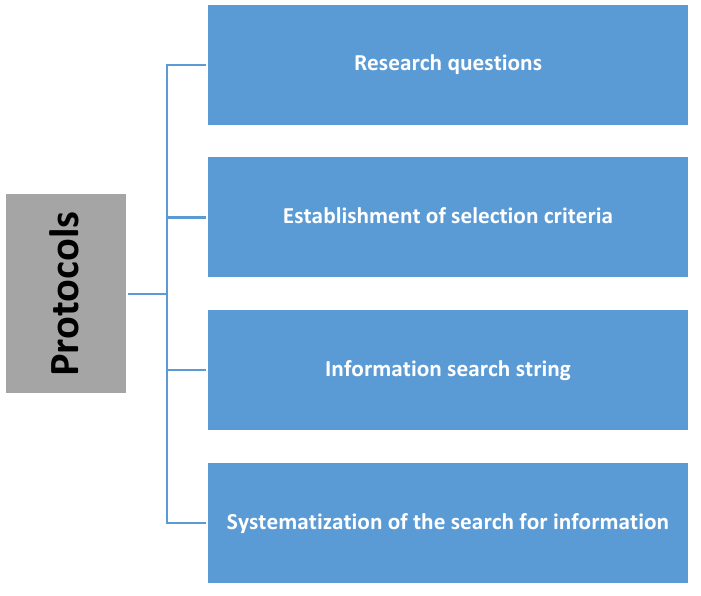
Figure 1. Methodological